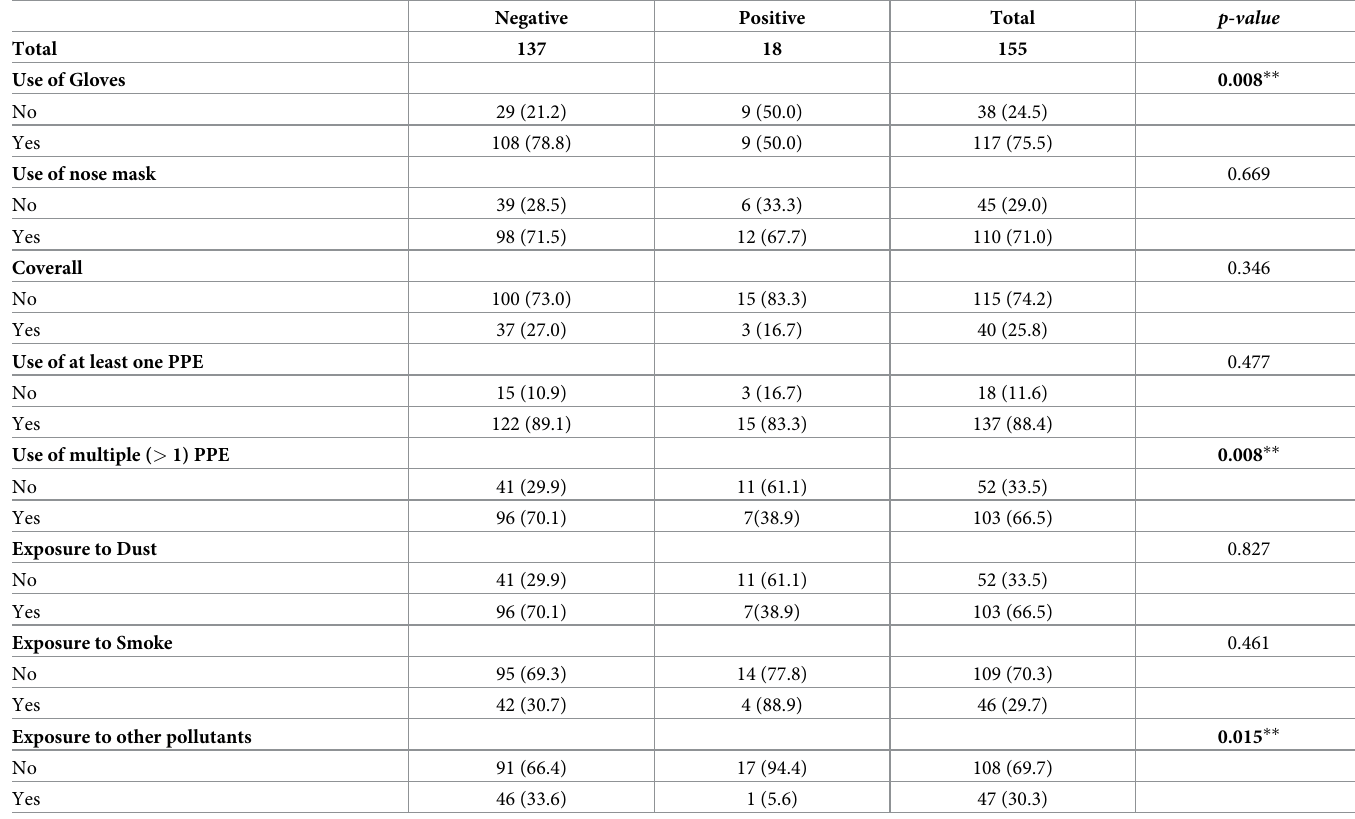
Table 3. Exposure to pollutants and the use of PPE.